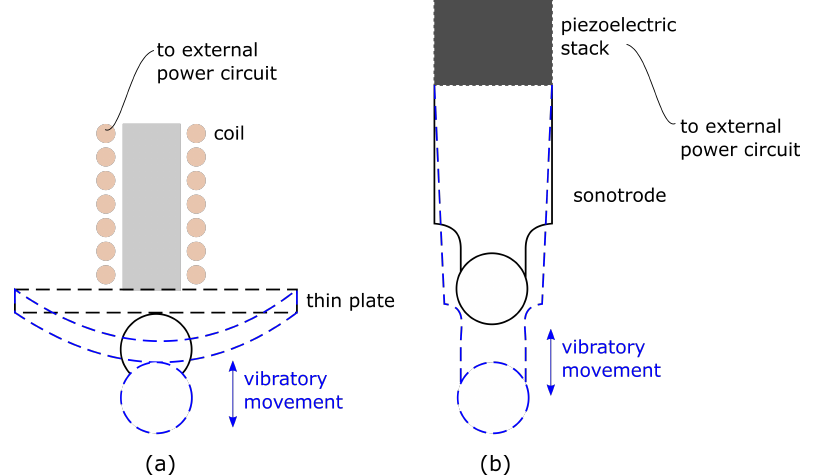
Figure 2. Schematic representations of VABB systems. ( a ). Systems based on deflective plates. ( b ). Systems based on sonotrode